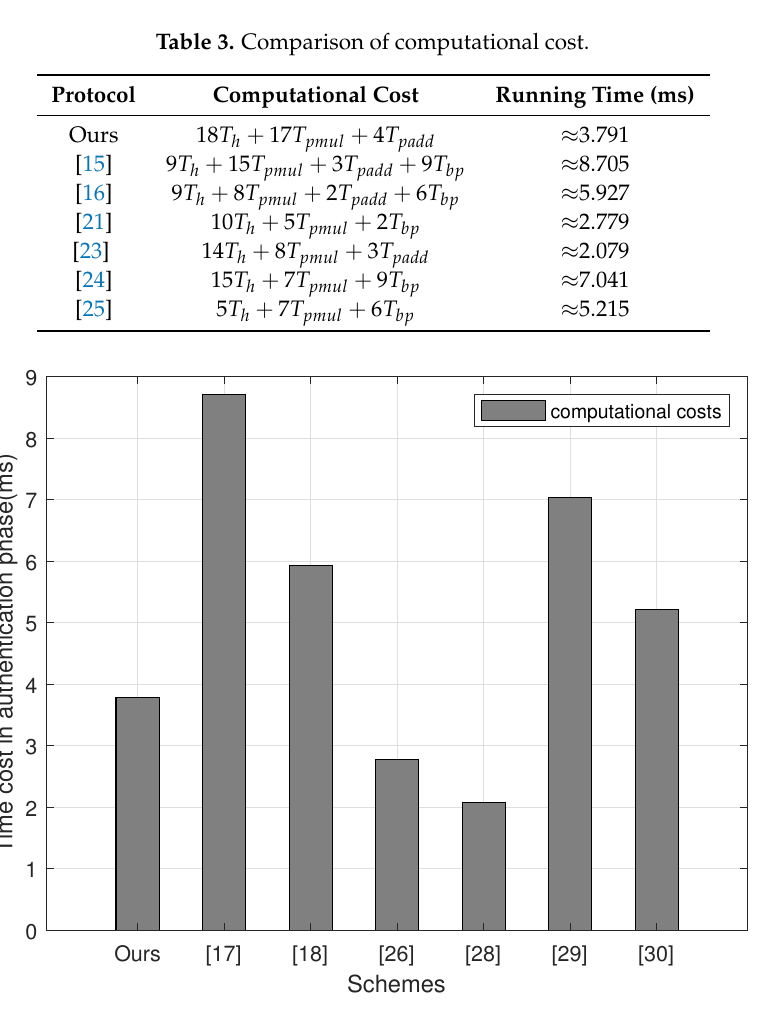
Figure 3. Computational costs of different authentication